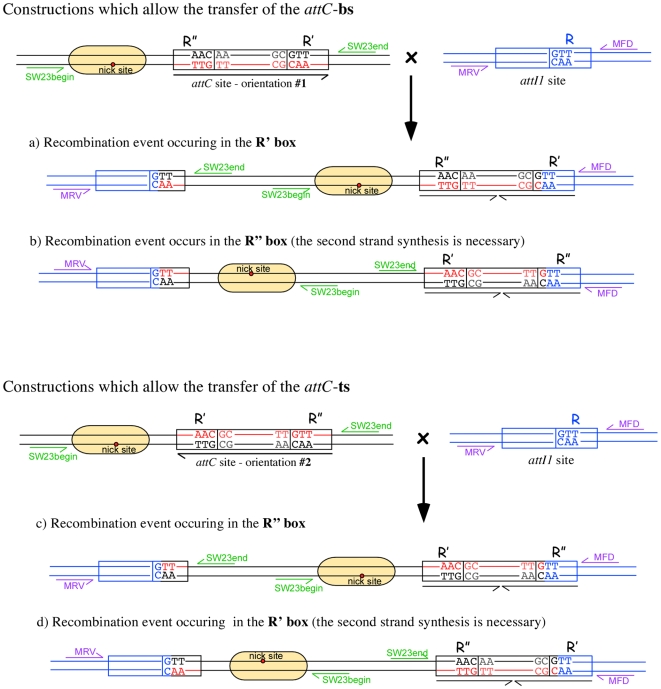
Possible recombination points of the attC×attI cointegrates and strategy to discriminate between them.The original plasmids containing the attC site (pSW-attC) and the attI site (pSU38-attI1) are represented by black and blue lines, respectively. The attC-bs appears in red, to facilitate the visualization of the attC site orientation in the cointegrates. The sequences of the recombination points of the newly formed attC and attI are shown. Four recombination events are represented: a, the recombination event occurring in the R' box after attC-bs transfer; b, the recombination event occurring in the R″ box after attC-bs transfer; c, the recombination event occurring in the R' box after attC-ts transfer; and d, the recombination event occurring in the R' box after attC-ts transfer. The positions and orientations of the oligonucleotides (SW23begin, Sw23end, MRV, and MFD) used in this study to confirm the attC×attI cointegrate formation and recombination point localization are shown in green. Note that each a, b, c, and d co-integrates has its own PCR signature.